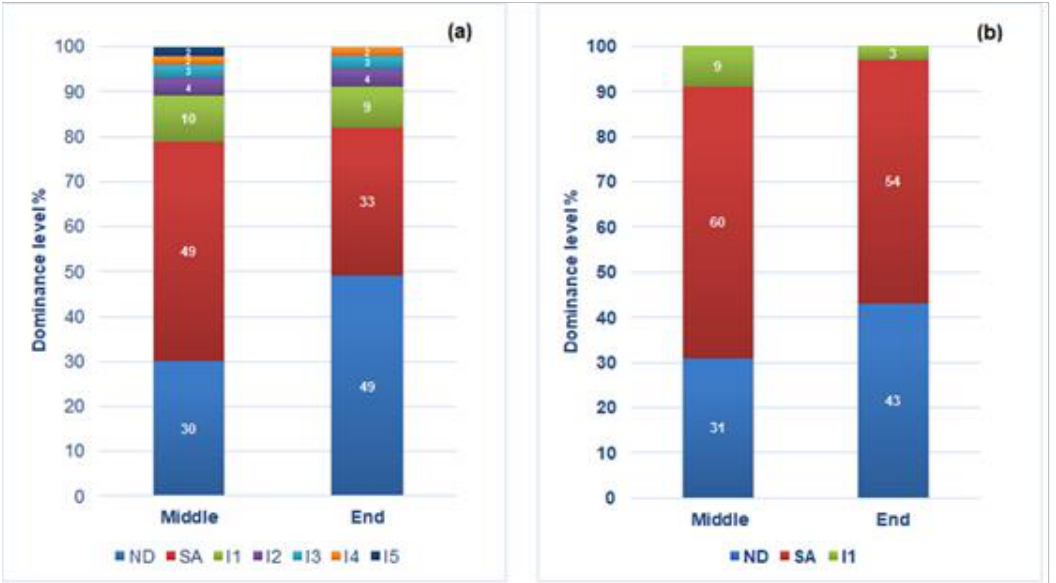
Figure 4. Dominance level of the mixed starter ND-SA used for the two pilot-scale vinifications, with ( a ) and without ( b ) SO 2 addition in the middle (50% of the sugar reduction) and the final phase of the fermentation.